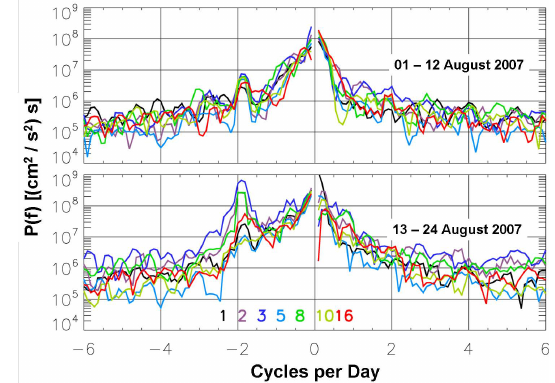
Fig. 13. Power spectra of ice-drift vector time series measured at 7 ice buoys (no. 1, 2, 3, 5, 8, 10, and 16) before (1–12 August 2007) and after (13–24 August 2007) the storm on 13 August 2007. Table 5. Maxima and minima of ice-drift divergence and vorticity oscillations on 13 August 2007 for eight triangles of the D07 buoy array.